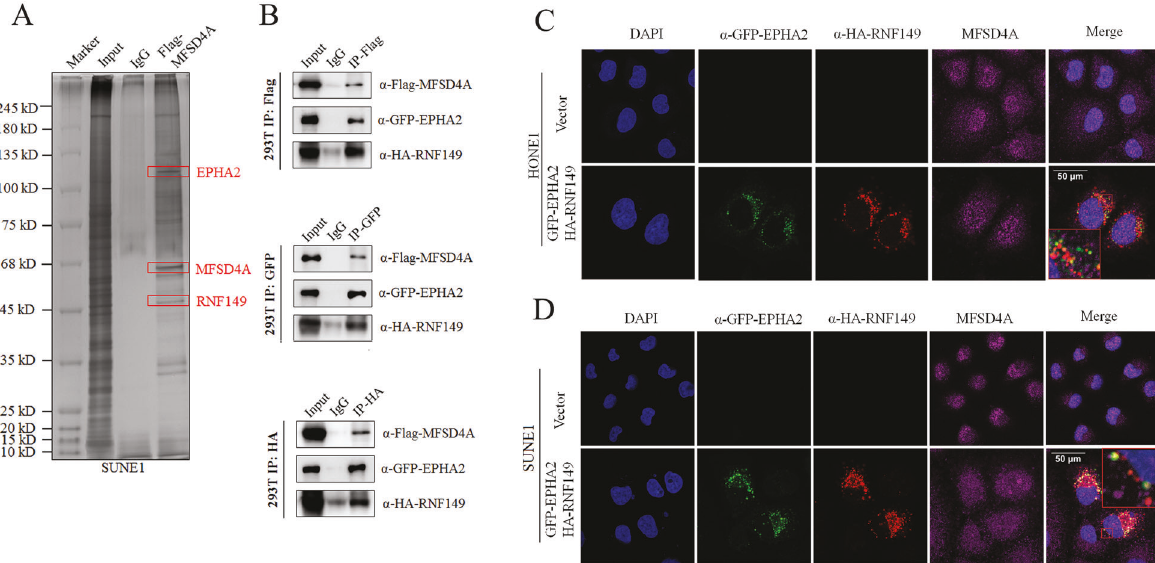
Fig. 4 MFSD4A interacts with EPHA2 and RNF149. A Immunoprecipitation (with anti-Flag antibodies or IgG) and SDS PAGE analysis of SUNE1 cells stably transfected with FLAG-MFSD4A. B Immunoprecipitation (with anti-Flag antibodies or IgG) and immunoblot analysis (with anti-GFP, anti-FLAG, and anti-HA antibodies) of 293 T cells transfected with plasmids encoding FLAG-MFSD4A, GFP-EPHA2, and HA-RNA149 (upper). Immunoprecipitation (with anti-GFP antibodies or IgG) and immunoblot analysis (with anti-GFP, anti-FLAG, and anti-HA antibodies) of 293 T cells transfected with plasmids encoding FLAG-MFSD4A, GFP-EPHA2, and HA-RNA149 (middle). Immunoprecipitation (with anti-HA antibodies or IgG) and immunoblot analysis (with anti-GFP, anti-FLAG, and anti-HA antibodies) of 293 T cells transfected with plasmids encoding FLAG-MFSD4A, GFP-EPHA2, and HA-RNA149 (lower). (C-D) MFSD4A could bind to GFP-EPHA2 and HA-RNF149 simultaneously in HONE1 ( C ) and SUNE1 ( D ) cells transfected with plasmids encoding GFP-EPHA2 and HA-RNF149, as assessed using immuno fl uorescence